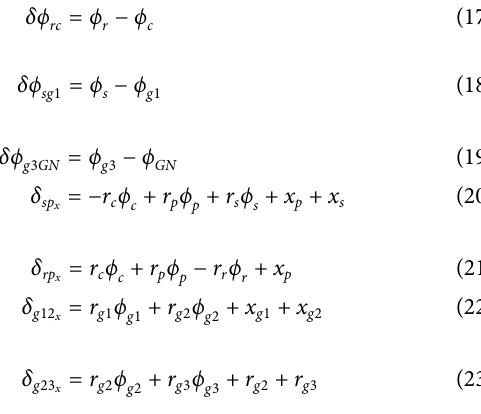
Equations 24 , 25 express the total kinetic and potential energy of the system, respectively. The eccentricity mass in the kinetic energy term can be expressed as the percentage of the radius. k b represents spring stiffness about the x and y directions of each component.